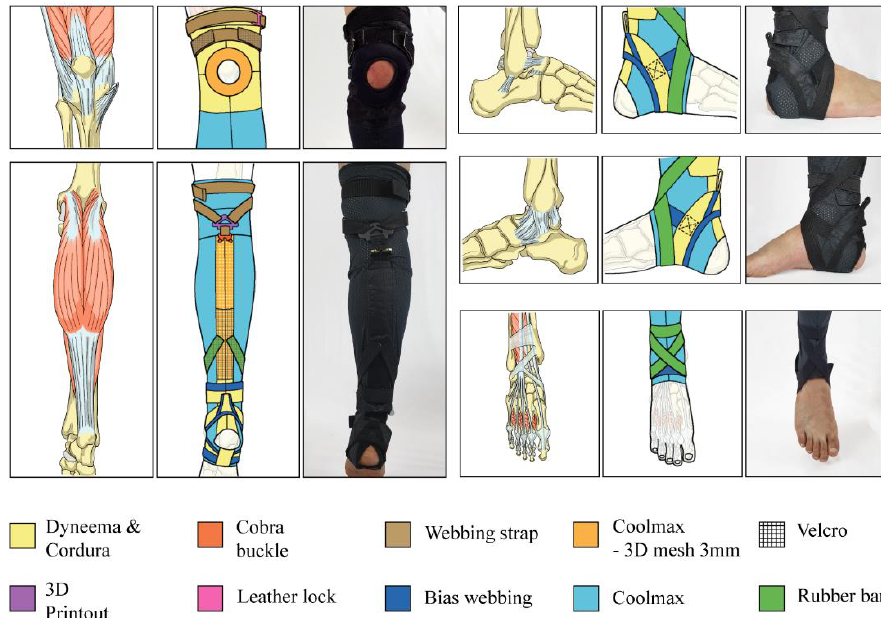
Figure 5. Parts of kneE-XOcks, designed by bio-inspired body anatomy, are made of eleven types of materials that ape the characteristics of body anatomy. As Dyneema and Cordura have high rigidity, they are used in parts that support and transmit the power of kneE-XOcks. Coolmax and 3D mesh have high breathability and cushioning, which increases the wearability of kneE-XOcks. Co- bra buckle, leather lock, webbing strap, and bias webbing connect each element of kneE-XOcks to each other, allowing kneE-XOcks to be composed as a single garment. Unnecessary surplus in kneE- XOcks can be minimized using Velcro and rubber bands.